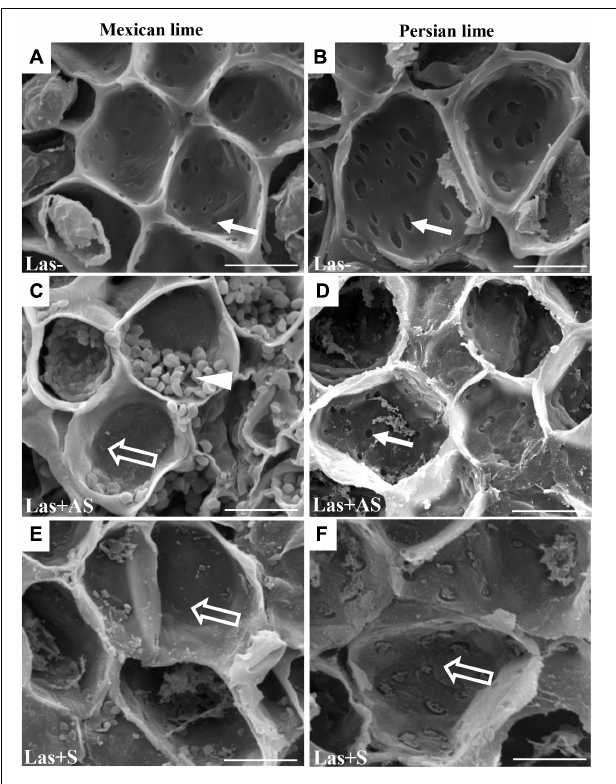
FIGURE 2 | SEM of phloem of the control (Las − ; A,B ) as well as infected petioles from leaves that were asymptomatic (Las + AS; C,D ) and symptomatic (Las + S; E,F ) from Mexican and Persian limes, respectively. White arrows indicate pores not plugged by callose depositions, whereas opened arrows indicate pores with callose depositions. White triangle indicates the presence of starch grains. Bars = 30 µ m.